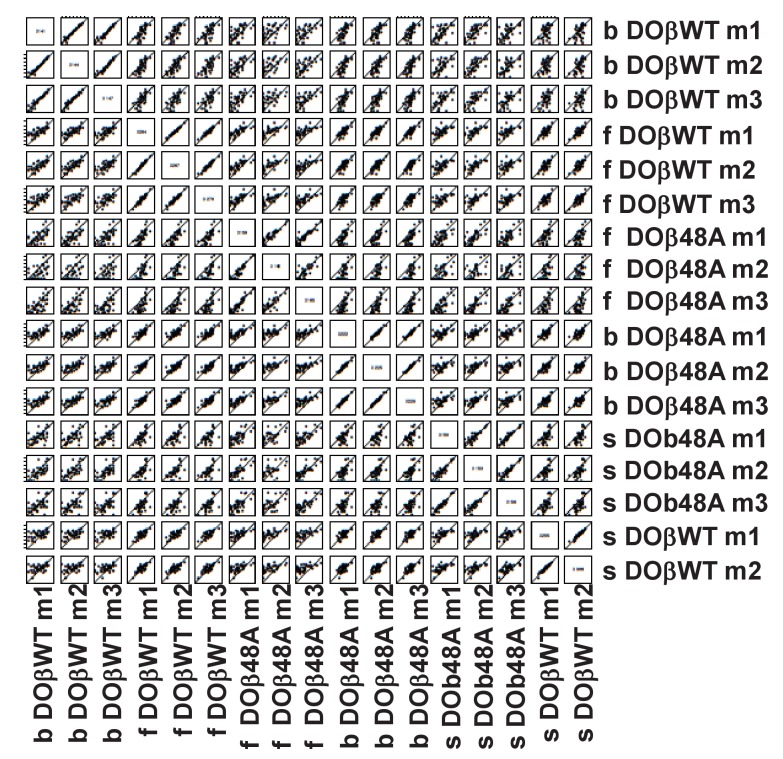
TRAJ usage by naive CD4 T cells depends on the selecting MHCII allele and partner TCRβ.Pairwise scatter plots of individual TRAJ frequencies between all replicates of mature naïve CD4 T cells from mice expressing different MHCII alleles. Each point is a TRAJ. Data are plotted as log2 transformed TRAV counts per 1 × 10^4 total TCRαsequences in each mouse noted on the x axis versus each mouse noted on the y axis. Values distributed along the diagonal are equivalent between the two mice compared in the plot. Individual mice of each genotype were numbered m1-m3, numbers for each mouse are used consistently throughout.